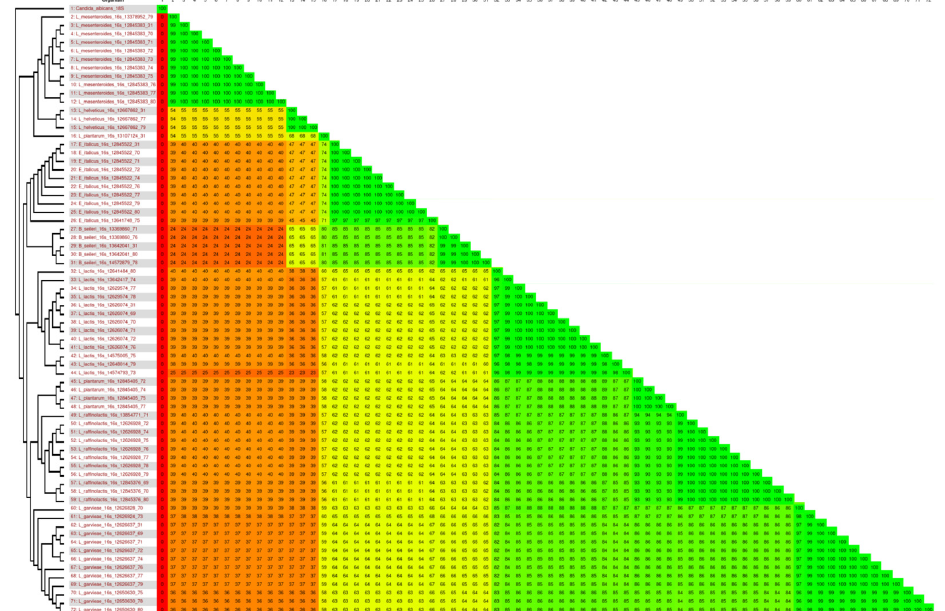
Figure 5. Phylogenomic tree analysis and heat map of the most abundant species in the samples. One sequence from each of the most abundant species was selected from the 13 artisanal cheese samples. Comparisons between the variable content of all strains were plotted as percentages of similarity on the heat map using Gegenees. The percent similarity was used to generate a phylogenomic tree with FigTree. The numbers 2 to 72 (left corner and at the top) represent the selected species. The number 1 is a yeast species that was used as an outgroup. The percentages were plotted with a spectrum ranging from red (low similEEarity) to green (high